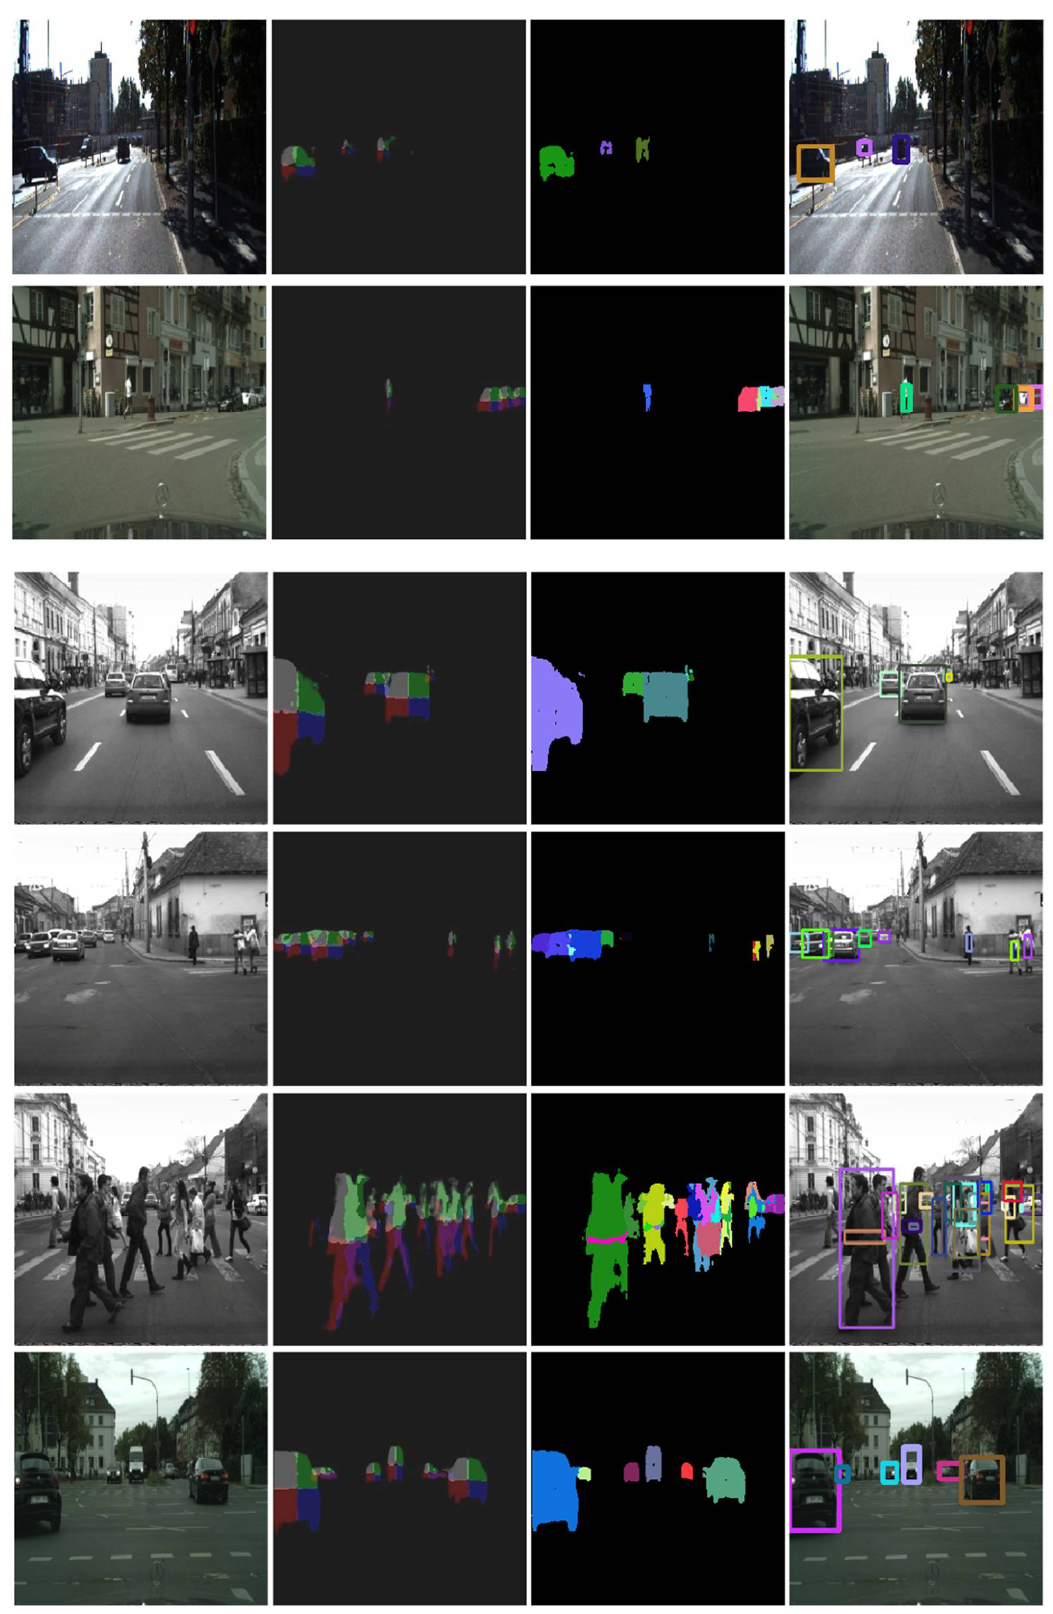
Figure 17. The first column represents the input image, while the second column is the quarter prediction (with the CNN output merged), the third column represents the labeling output, and the fourth column is the resulting bounding boxes of the individual obstacles.